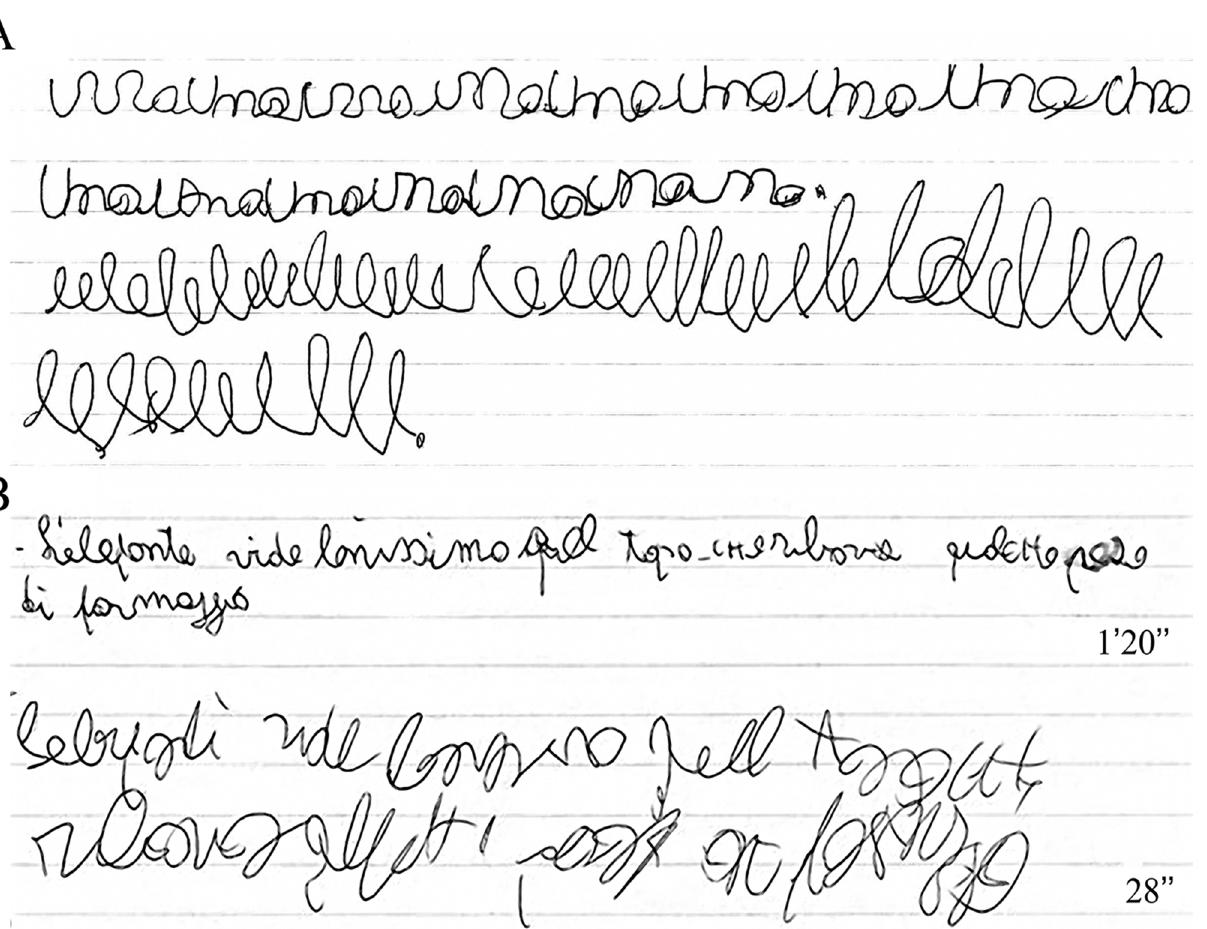
Fig 2. Handwriting performance. (A) Patient 12. Example of handwriting during “ uno “ (above) and “ le ” (below) test. The child performed slowly. (B) Patient 9. Example of handwriting performance during ‘ best ’ (above) and ‘ faster ’ (below) conditions. We considered this patient ’ s performance as